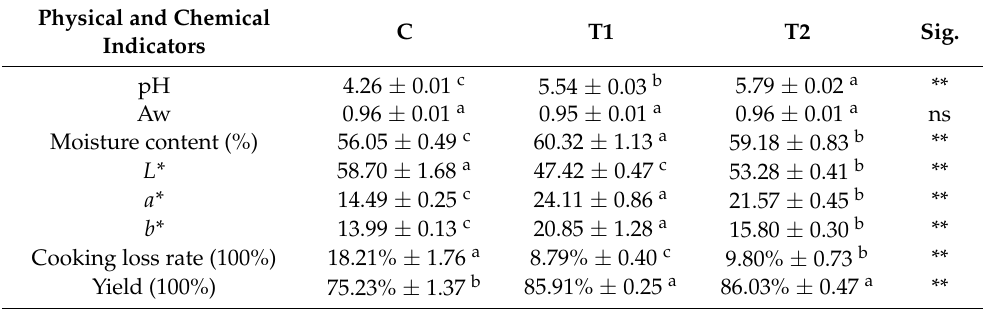
Table 2. The effect of the improvement in pH, water activity, water content and color of MPR. Physical and Chemical Indicators